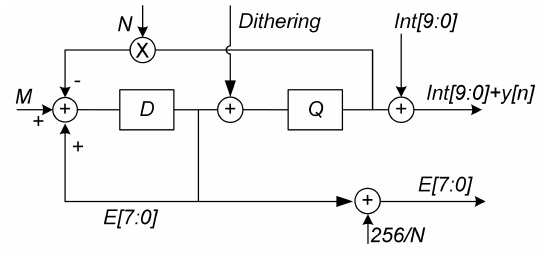
Figure 4. Diagram of the DSM.